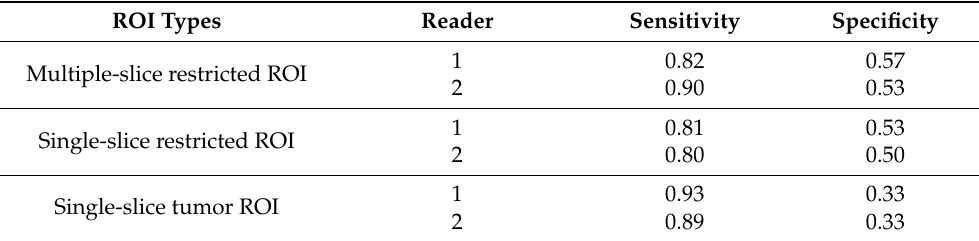
Table 4. Sensitivity and Specificity at optimal operating point using Youden’s